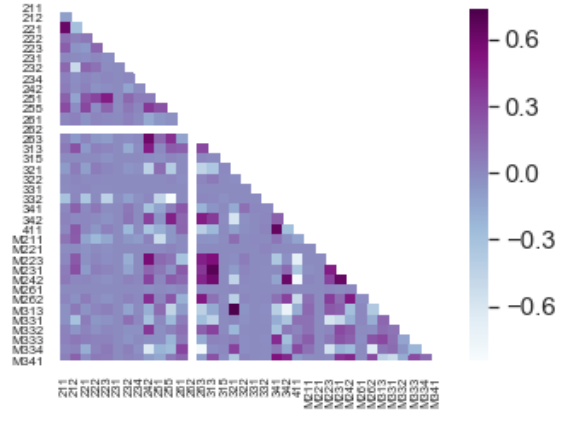
Figure 6. Bayesian cross-correlations between USA ecological